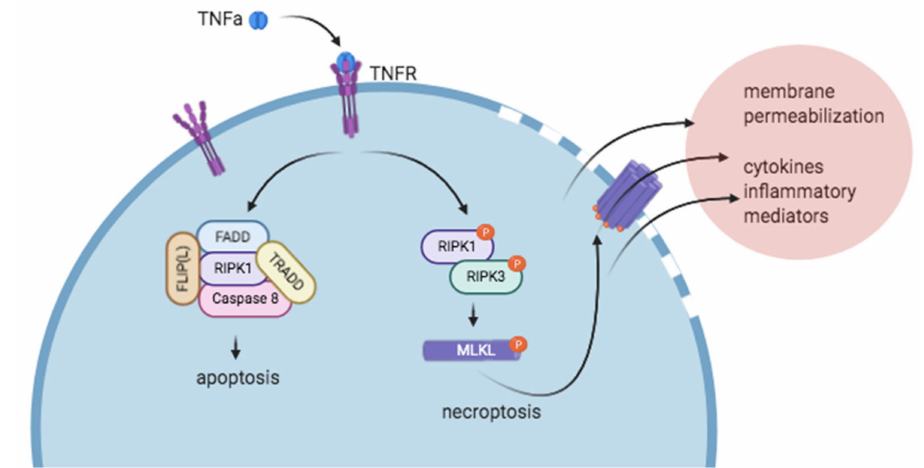
Figure 1. Simplified version of necroptosis signal transduction events downstream of tumor necrosis factor- α / tumor necrosis factor receptor (TNF α / TNFR) interactions. Soluble TNF α binds TNFR and can trigger the formation of a pro-apoptotic (left, complex I) or pro-necroptotic (right, complex IIb) complex. In the absence of caspase-8 and presence of RIPK3, the pro-necroptotic complex IIb forms. After phosphorylation of RIPK1 and RIPK3, RIPK3 phosphorylates MLKL, which subsequently oligomerizes and is thought to insert into the cell membrane, forming pores. After cell membrane permeabilization, ion flux occurs, and intracellular contents are relapsed into the extracellular environment. Figure created with